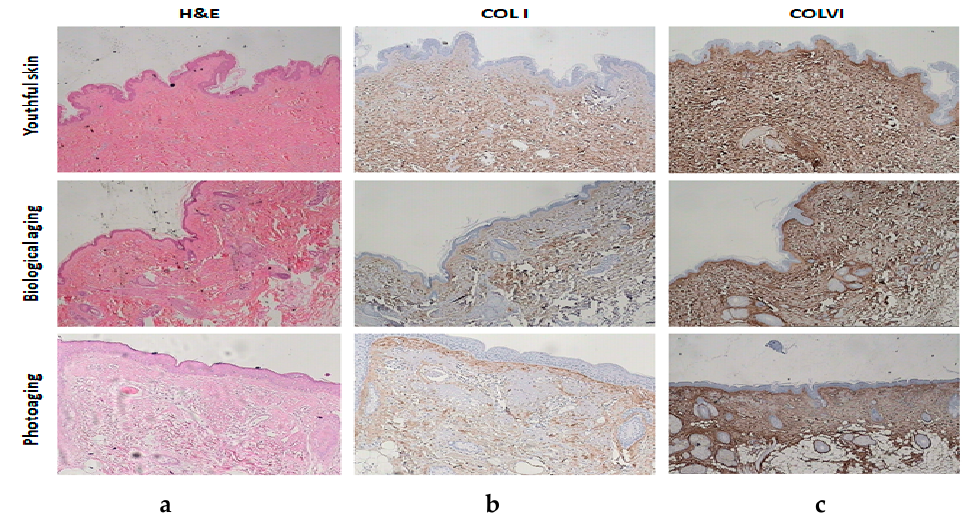
Figure 5. ( a ) Histochemical stainings of hematoxylin–eosin: youthful tissue, biological aging, and photoaging. ( b ) Anti-COL I stainings: youthful tissue, biological aging, and photoaging. ( c ) Anti-COL VI stainings: youthful tissue, biological aging, and photoaging.